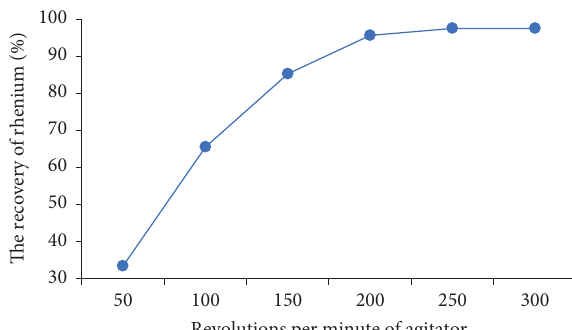
Figure 5: Infuence of stirring speed on the degree of rhenium extraction ( S : L � 1:3, process duration: 30 minutes, and temperature: 70 ° C).